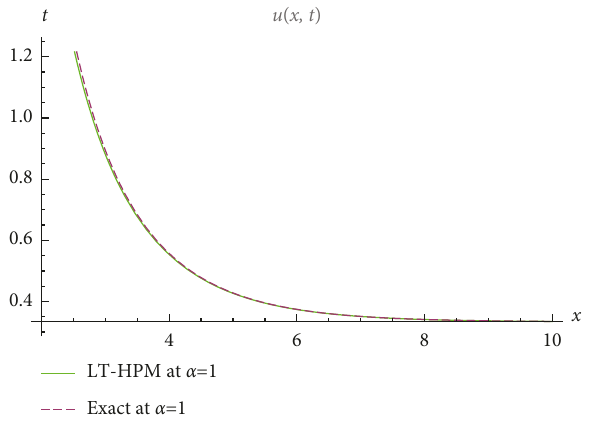
Figure 4: Error distribution between the approximate solution and the exact solution at. α